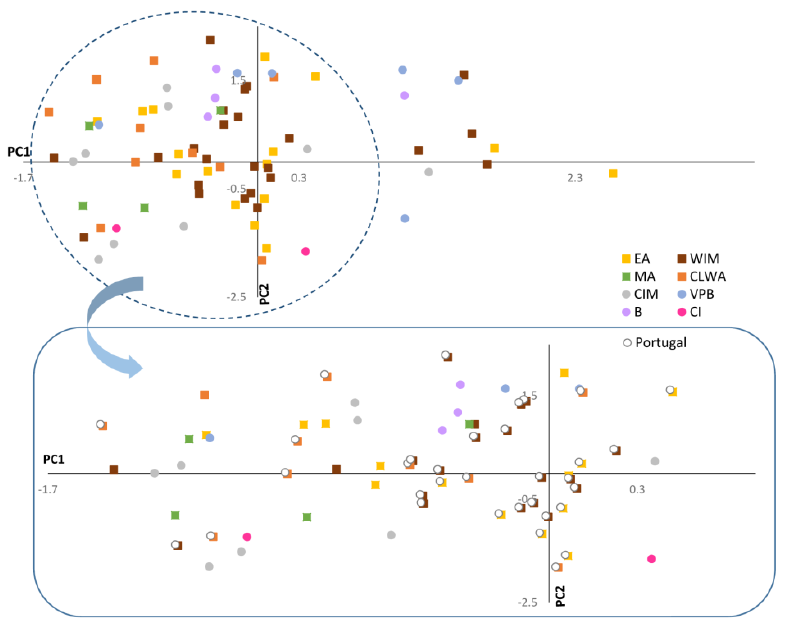
Figure 6. Scatter plot for the PCA analysis performed on the Iberian collection. Portuguese peppers are highlighted with a white circle. EA = European Atlantic, BP = Betica Province, CIM = Central Iberian Mediterranean, CLWA = Coastal Lusitania and West Andalusia, MA = Murcia and Almeria, VPB = Valencia-Provence and Balearic, WIM = West Iberian Mediterranean, CI = Canary Islands.